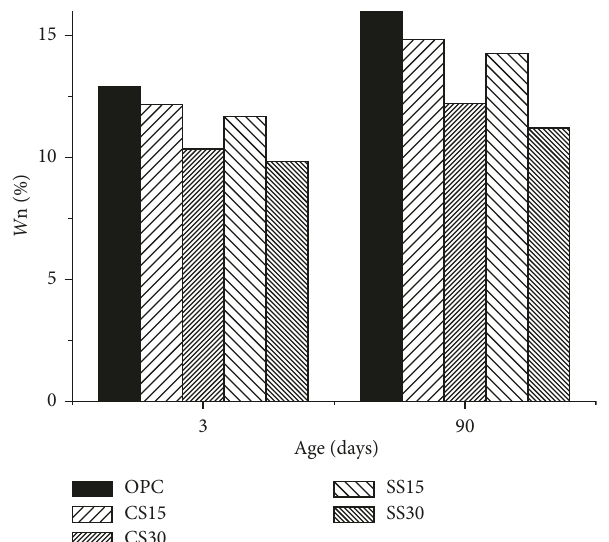
Figure 6: The nonevaporable water content ( W TG test.